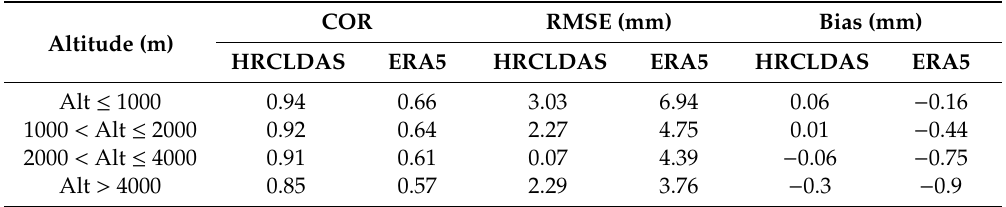
Table 3. The COR, RMSE and bias of precipitation of HRCLDAS and ERA5 at di ff erent altitudes. COR RMSE (mm) Bias (mm) Altitude (m) HRCLDAS ERA5 HRCLDAS ERA5 HRCLDAS ERA5 Alt ≤ 1000 0.94 0.66 3.03 6.94 0.06 − 0.16 1000 < Alt ≤ 2000 0.92 0.64 0.91 Alt > 4000 0.85